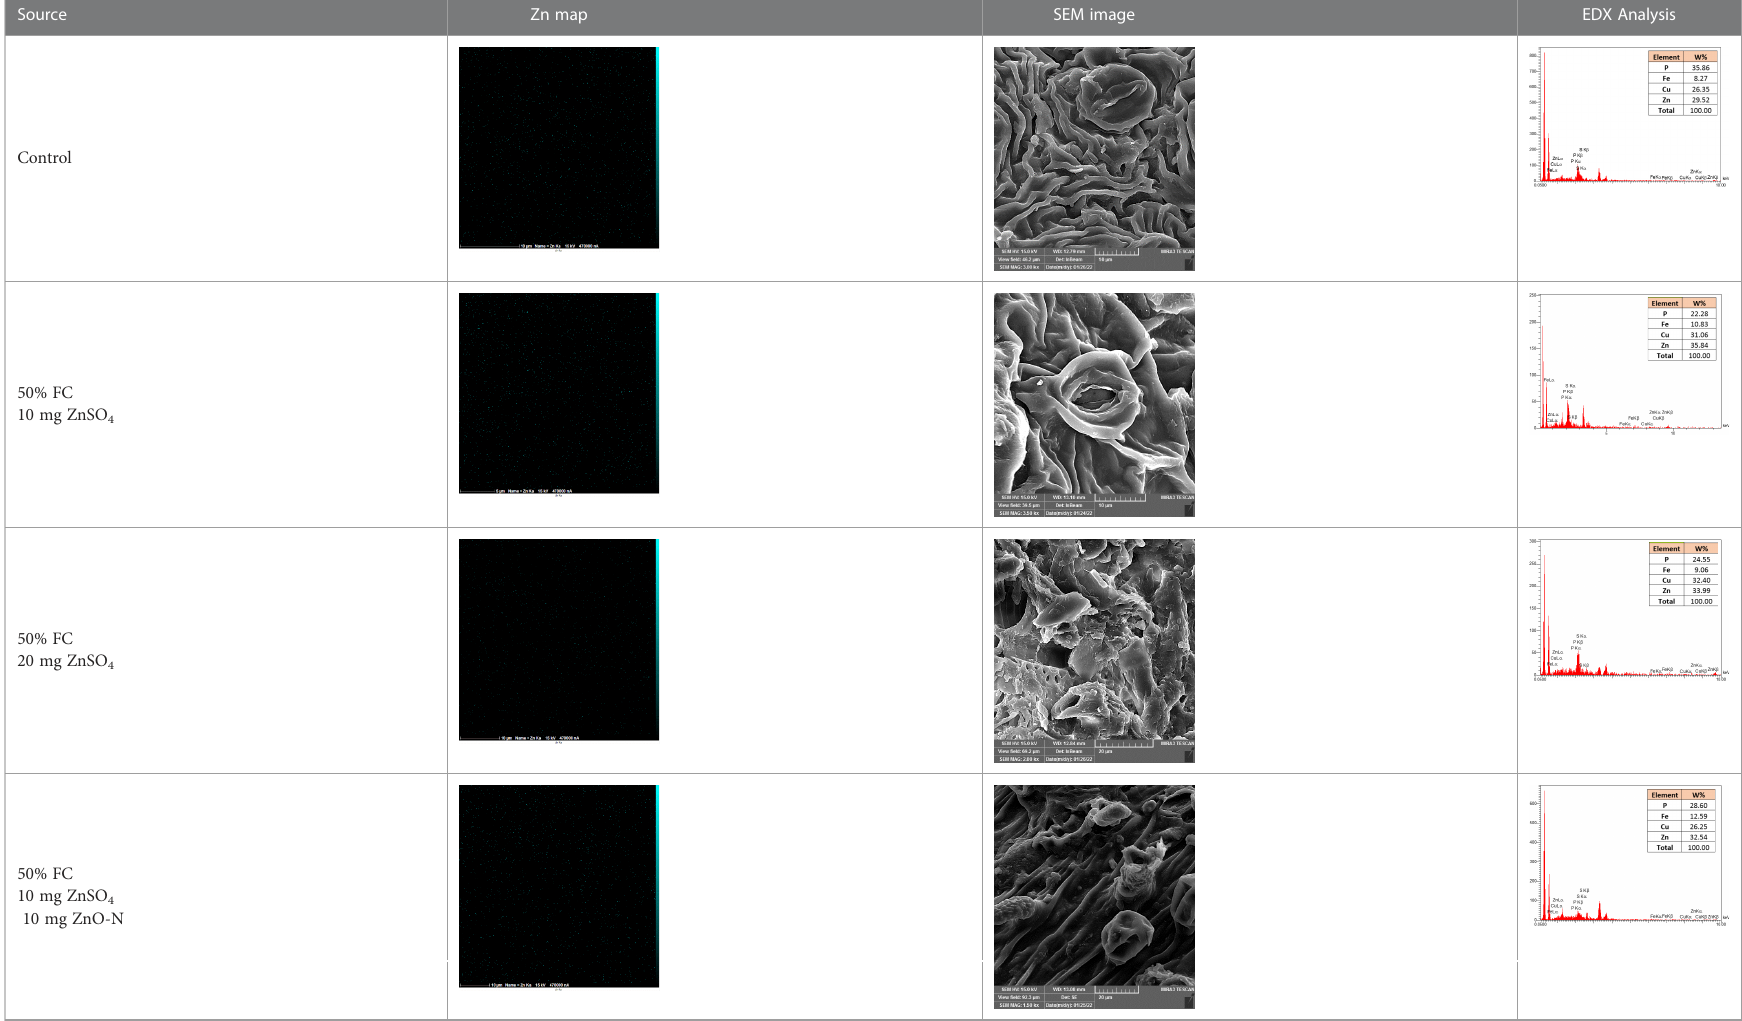
TABLE 2 Scanning electron microscopy images, Zn maps of leaf surfaces and their EDX results of non-fertilized (control) and foliar fertilized with ZnSO 4 and ZnO-N in D. kotschyi under drought